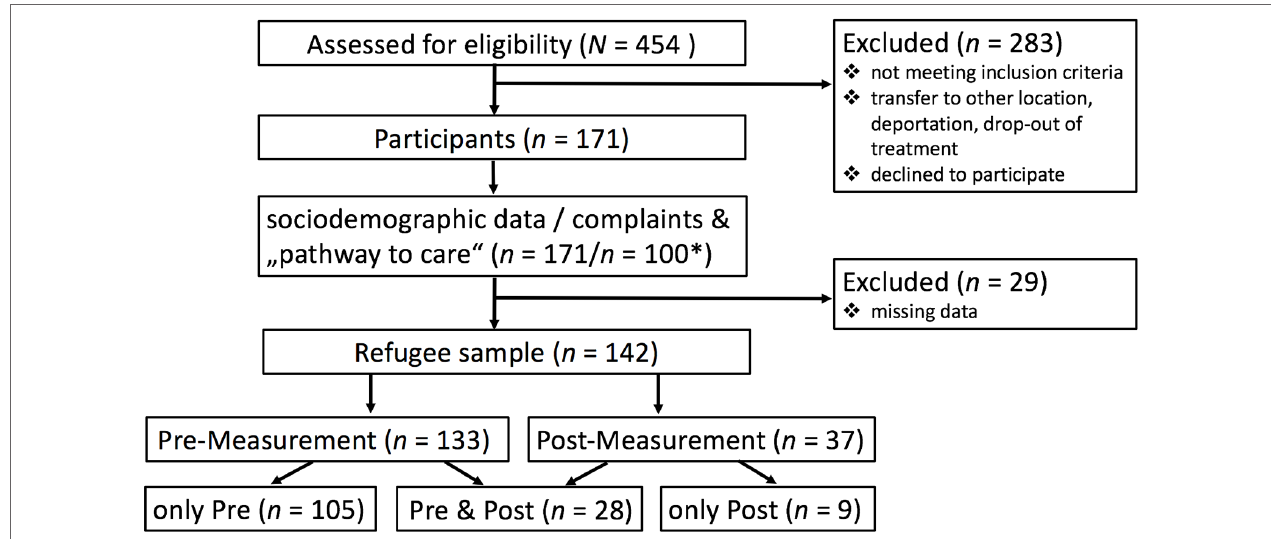
FIGURE 2 | Refugee sample. * Due to the naturalistic design of the study and the hardships of data collection along the treatment process, the information about complaints and “pathway to care” is missing for 71